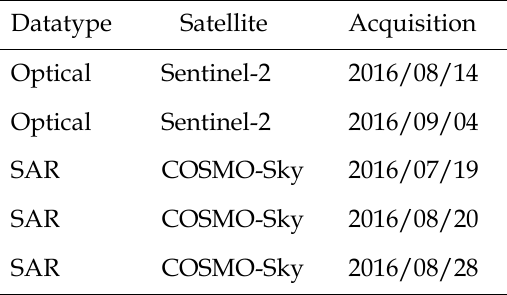
Table 1: EO data